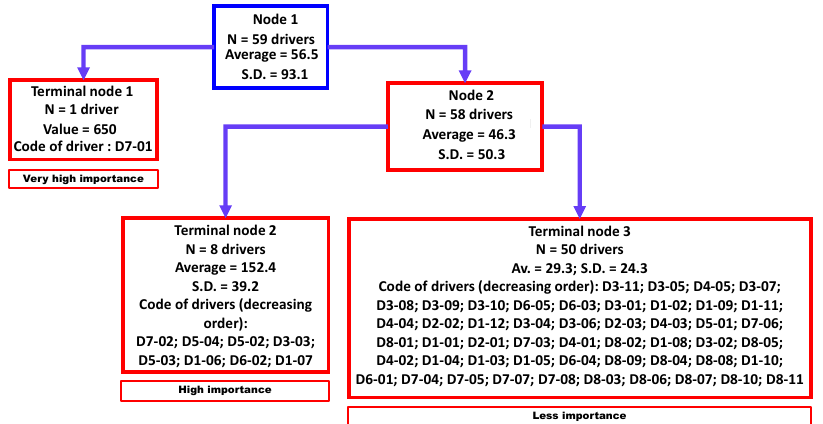
Figure 3. Aggregation of drivers of the observed emergence or increasing incidence of TBE in humans into three homogenous groups using a regression tree analysis. Legend: N, number; SD, standard deviation. D1-01 to D8-11 refer to a speci fi c driver (for the codi fi cation, see Table A1).